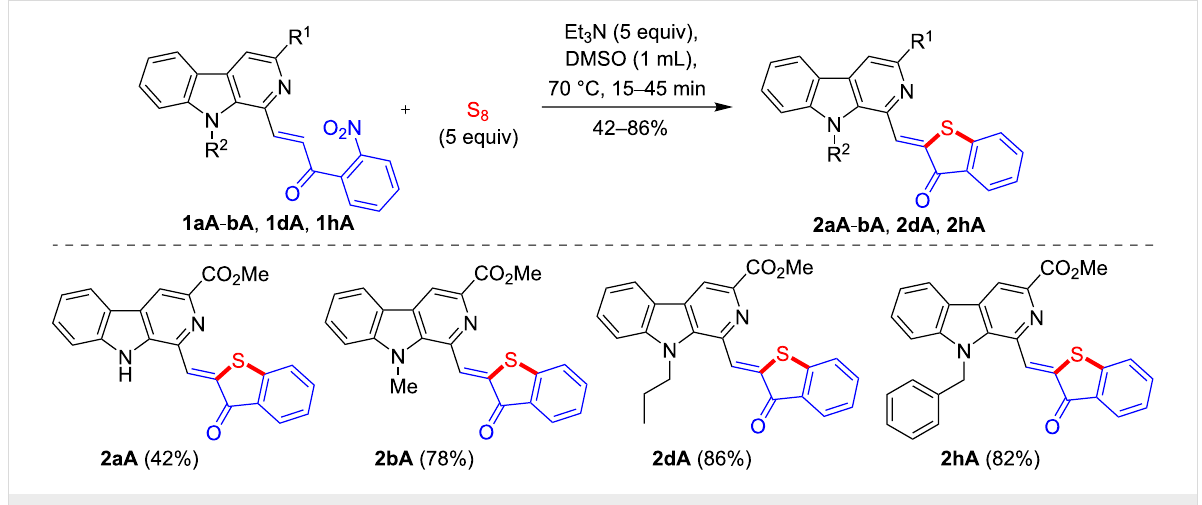
Scheme 2: Synthesis of β -carboline-linked benzothiophenone frameworks.